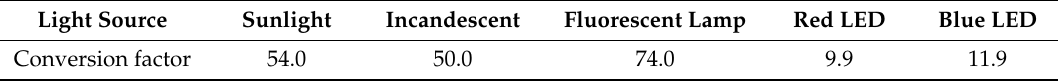
Table 3. The conversion from lux to PPFD varies under different light sources